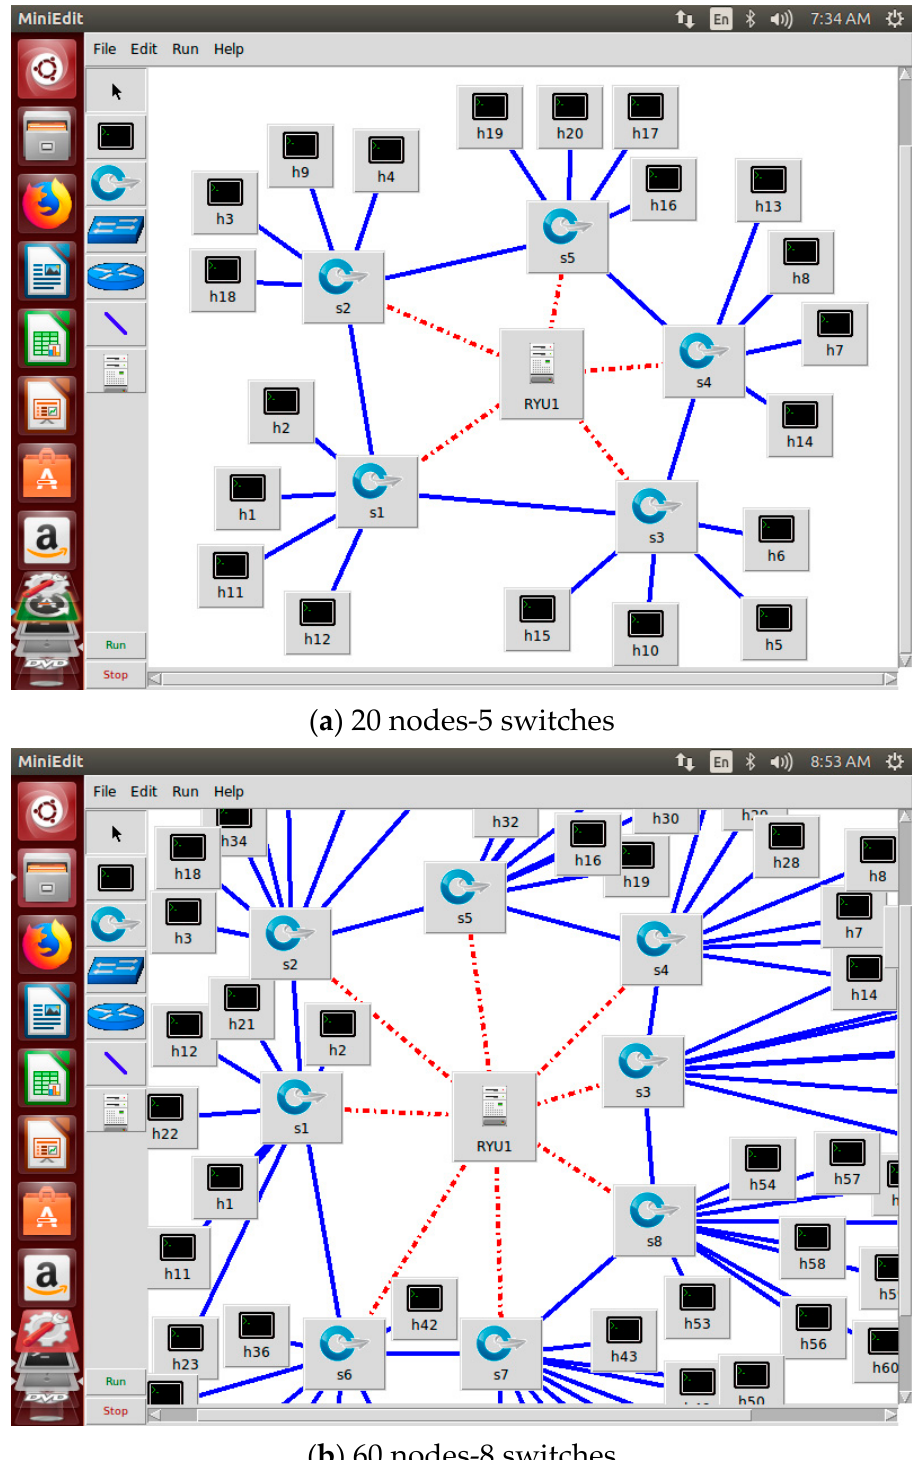
Figure 9. MADDPG set up in Mininet. 7.2.2. Jitter Jitter in SDN represents the small intermittent delay in data transmission. It is caused by a number of factors including network congestion, interference, and colli- sions. Jitter represents the variation in the delay of packets transmitted from the source to destination